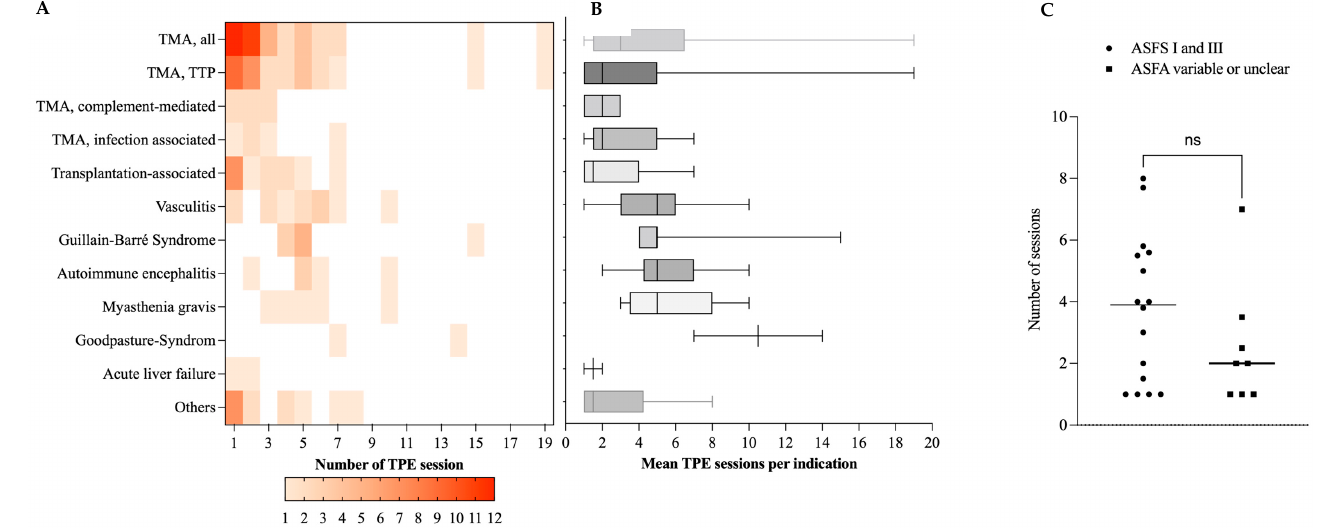
Figure 2. Number of TPE sessions per indication. ( A ) Heatmap showing the absolute number of TPE sessions per indication. Color coding represents mean session numbers (legend below graph). ( B ) Mean TPE sessions with SD. ( C ) Mean and SD of TPE session performed in patients with indications according to ASFA category. Abbreviations: TTP—Thrombotic thrombocytopenic purpura, TMA—Thrombotic microangiopathy, SD—standard deviation. Others: acute liver failure (n = 2), macrophage activation syndrome (n = 1), progressive bulbar palsy (n = 1), idiopathic hypertriglyceridemia (n = 1), polytrauma-associated coag- ulopathy (n = 1), anti-IgLON5-associated encephalopathy (n = 1), systemic sclerosis (n = 1), chronic in fl ammatory demyelinating neuropathy (n = 1), postpartum microangiopathy (n = 1), Miller-Fisher Syndrome (n = 1), polyradiculoneuritis (n = 1), paraneoplastic neurological syndrome (n = 1), catastrophic antiphospholipid syndrome (n = 1), acute demyelinating neuropathy (n = 1), hypergammaglobulinemia (n = 1). ns—not signi fi cant ( p = 0.226) (Mann-Whitney test).